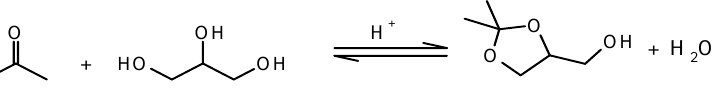
Figure 2 . Proton-catalyzed condensation reaction of acetone and glycerol to produce solketal. Solketal is produced from glycerin by means of a proton-based condensation reaction. It exhibits both alcohol and ketal functionality. In terms of fuel properties, solketal showed interesting properties in gasoline as it increases anti-knock properties [21]. In addition, more polar properties and a lower carbon chain length of fossil gasoline allow for higher blending capability. Furthermore, alcohols are also interesting drop-in components for diesel fuel. They increase the regeneration capacity of the diesel fuel while simultaneously increasing the molecular oxygen density. The lower number of C-C bonds and the absence of double bonds results in cleaner combustion with less soot formation [22]. However, the improvement in anti-knock properties is accompanied by a decrease in cetane number [23]. In addition, solketal has a relatively low heating value, which can lead to driving range problems [24]. Considering the properties of solketal, it is reasonable to blend solketal